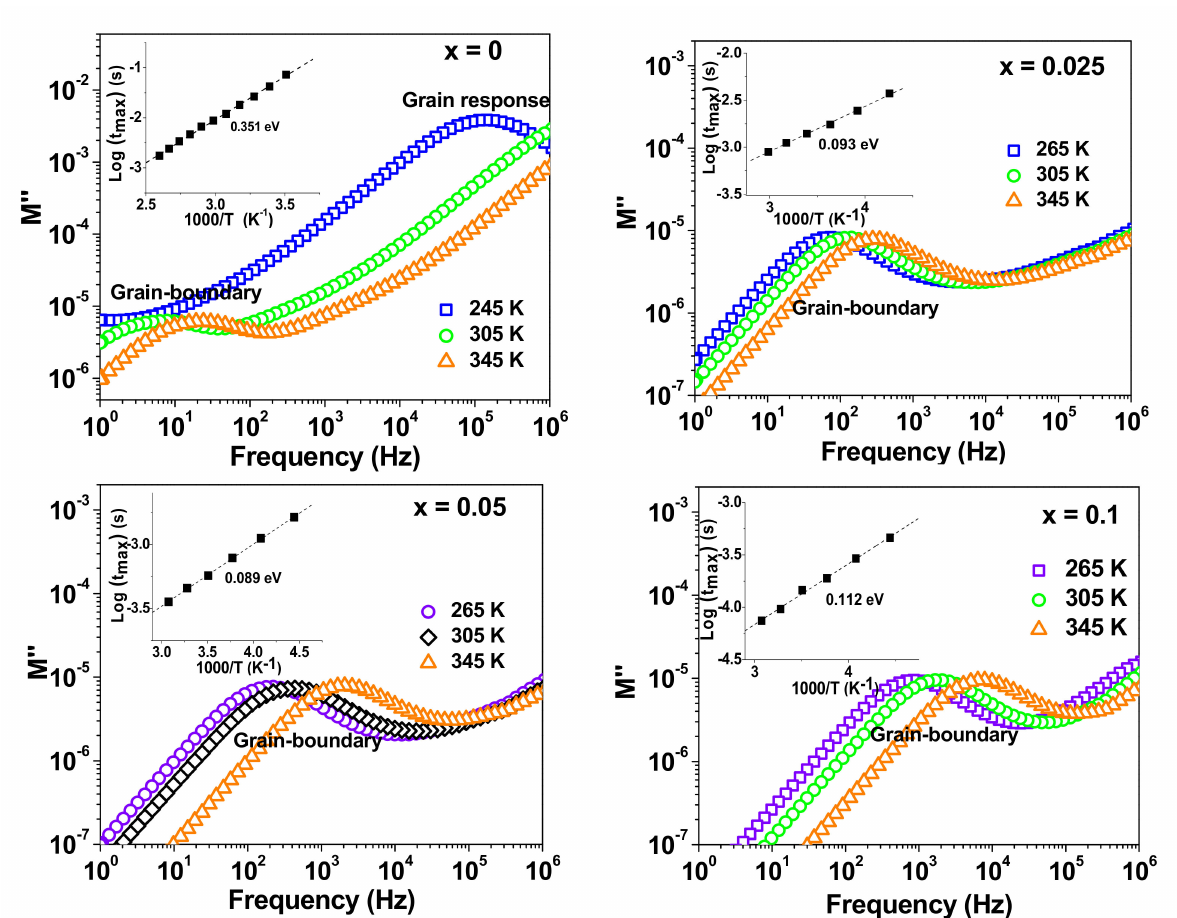
Figure 8. Frequency dependence of M (cid:48)(cid:48) at different temperatures for NSTO